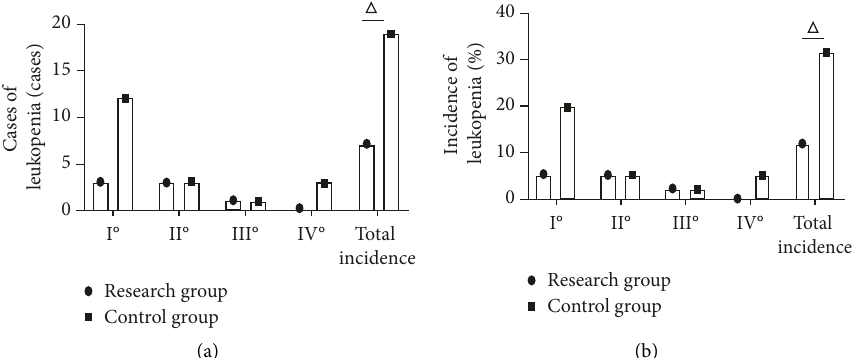
Figure 5: Comparison of occurrence of leukopenia for both groups. Note: Δ is the difference between the two groups, P < 0 . 05. (a) Cases of leukopenia (cases) and (b) incidence of leukopenia